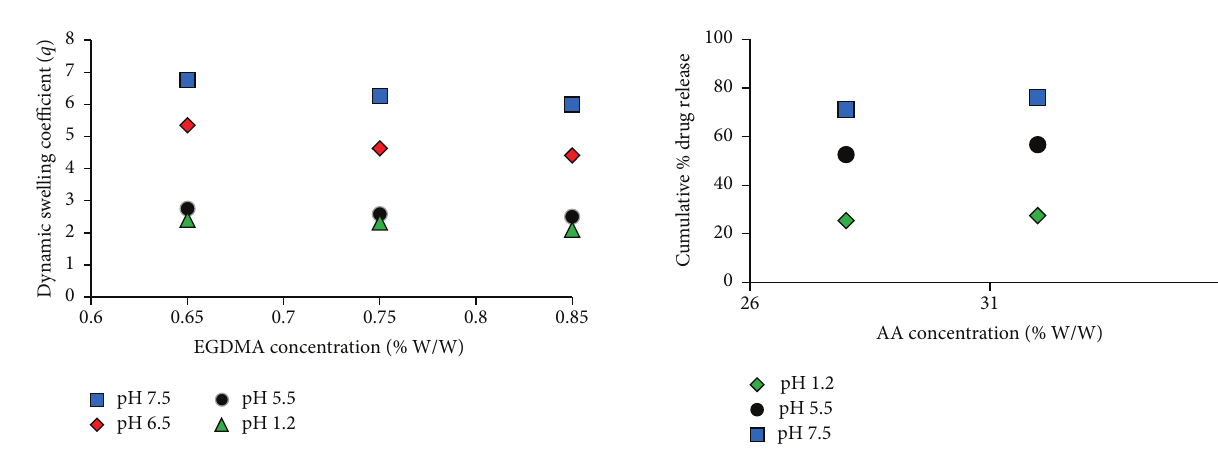
Figure 6: Dynamic swelling coefficient of AA/Gelatin hydrogels with different concentrations of EGDMA as cross-linking agent (0.65%, 0.75%, and 0.85% of acrylic acid) in 0.05 M USP phosphate buffer solutions of different pH values at 37 ∘ C.